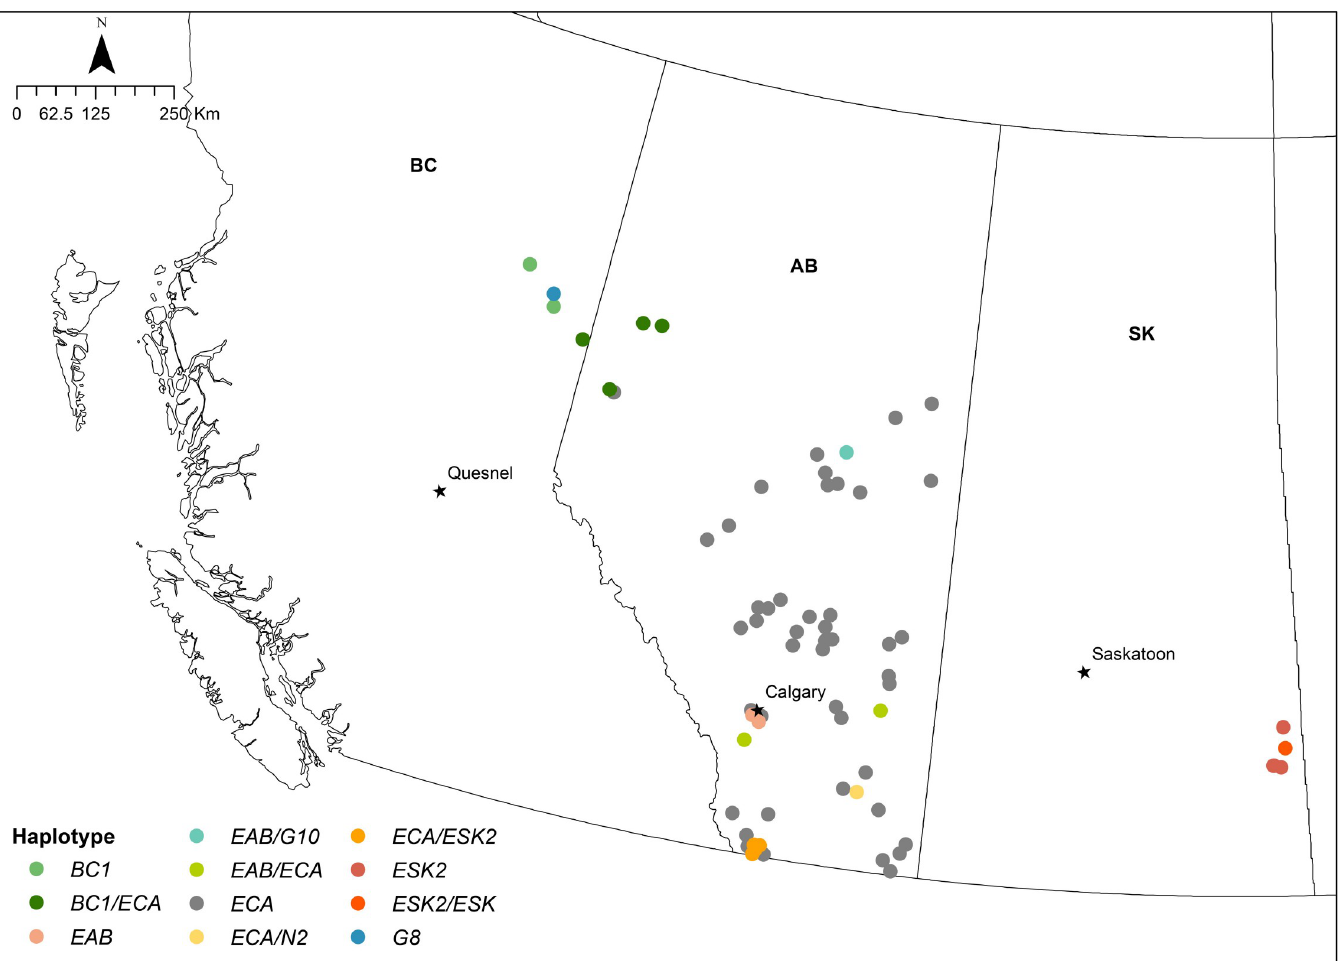
Fig 1. Distribution of E . multilocularis and E . granulosus s . l . haplotypes in western Canada. The map shows the distribution of E . multilocularis and E . granulosus s . l . haplotypes in the provinces of British Columbia (BC), Alberta (AB), and Saskatchewan (SK). Different colours are used to represent each haplotype in single and mixed infections. The Em EAB and N2 were only found in Alberta, and the ECA was the most prevalent in that province. Haplotypes from British Columbia (BC1) were not found in Saskatchewan and the ESK2, the most prevalent haplotype in Saskatchewan, was not found in BC. Basemap layer available from: https://www12.statcan.gc.ca/ census-recensement/2011/geo/bound-limit/bound-limit-2016-eng.cfm.fig.